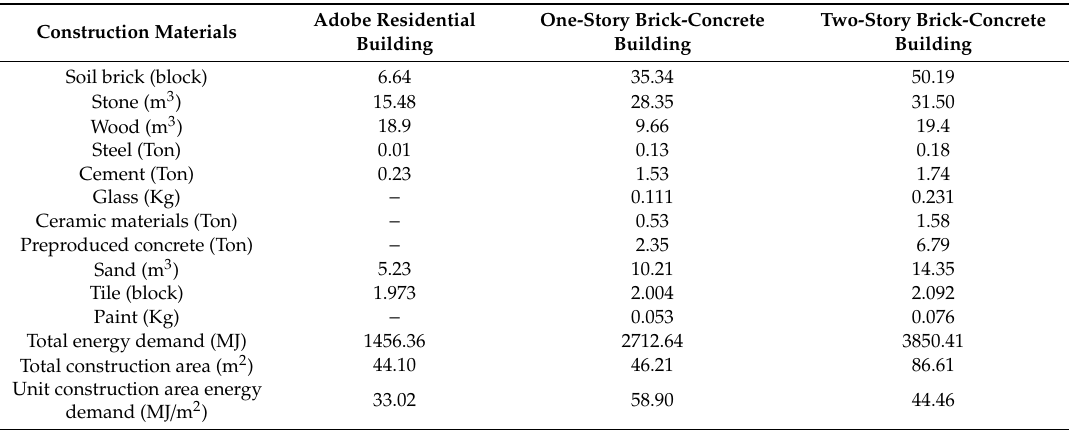
Table 6. Energy demand for the transportation of building materials in residential buildings (MJ).